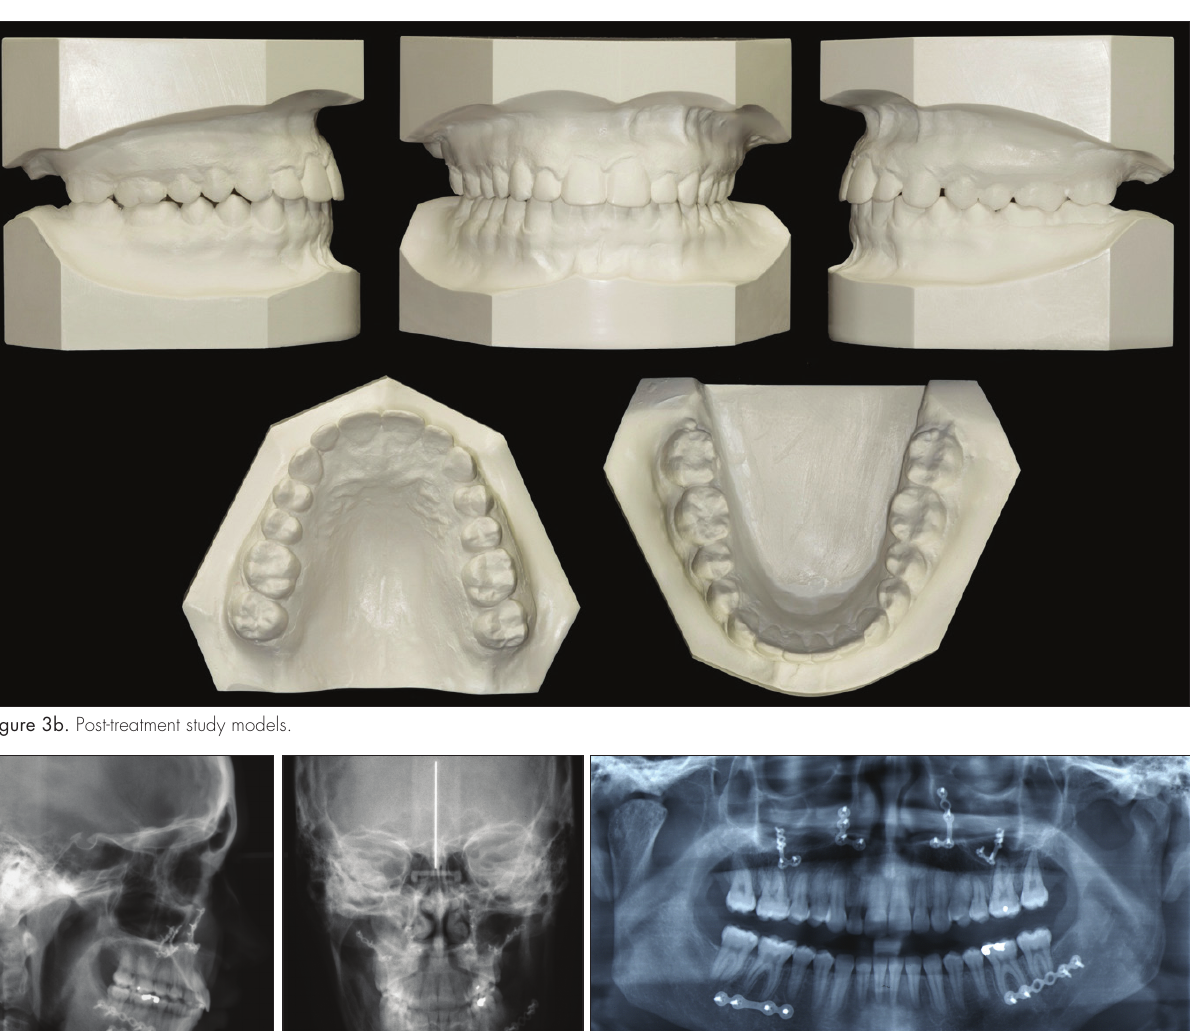
Figure 3d. Post-treatment panoramic.